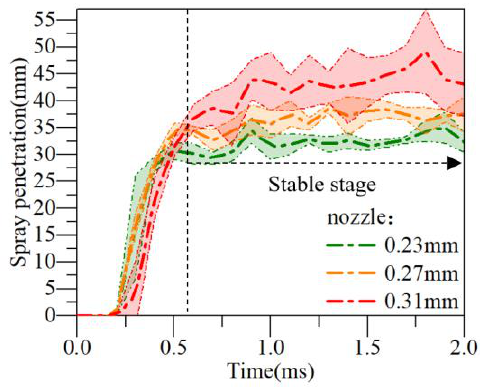
Figure 8. Spray penetration.